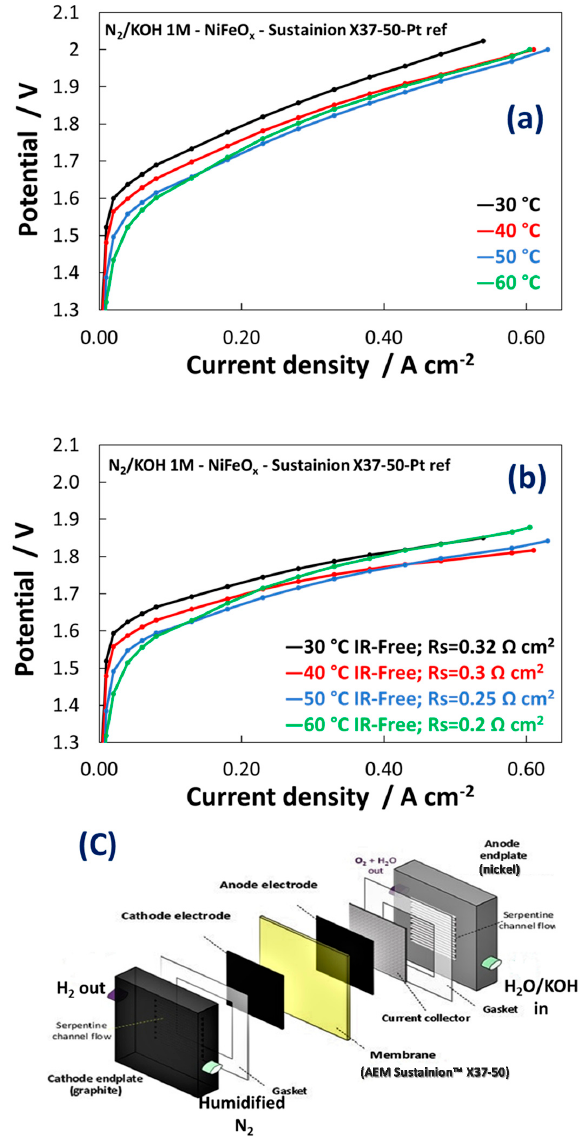
Figure 7. ( a ) Polarization curves carried out at 1 M KOH for MEAs including the NiFeO x -based electrocatalysts at the anode; ( b ) IR-free polarisation curves; ( c ) Schematic illustration of the AEM electrolysis cell used in these